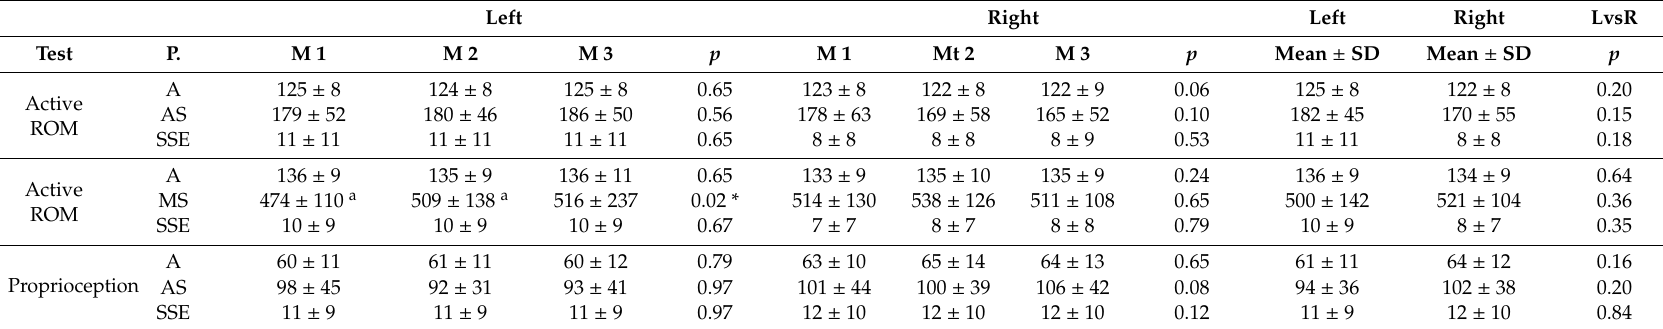
Table 1. Results for range of motion, arbitrary and maximum movement speed, and the sum of squared errors (SSE) when actively flexing the knee, and results presenting the ability to return to a given flexion (mean value ±